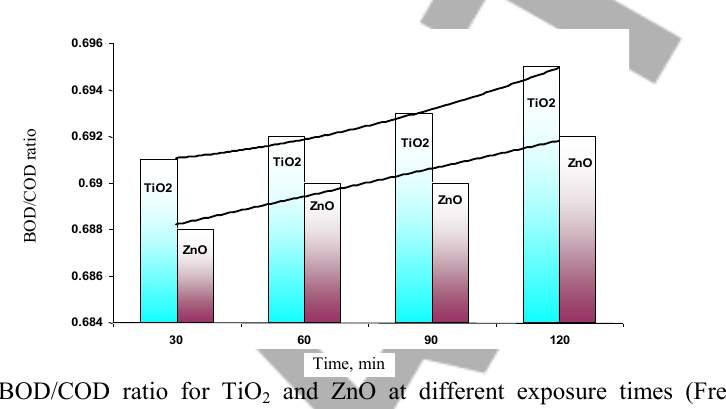
and ZnO at different exposure times (Frequency= 2